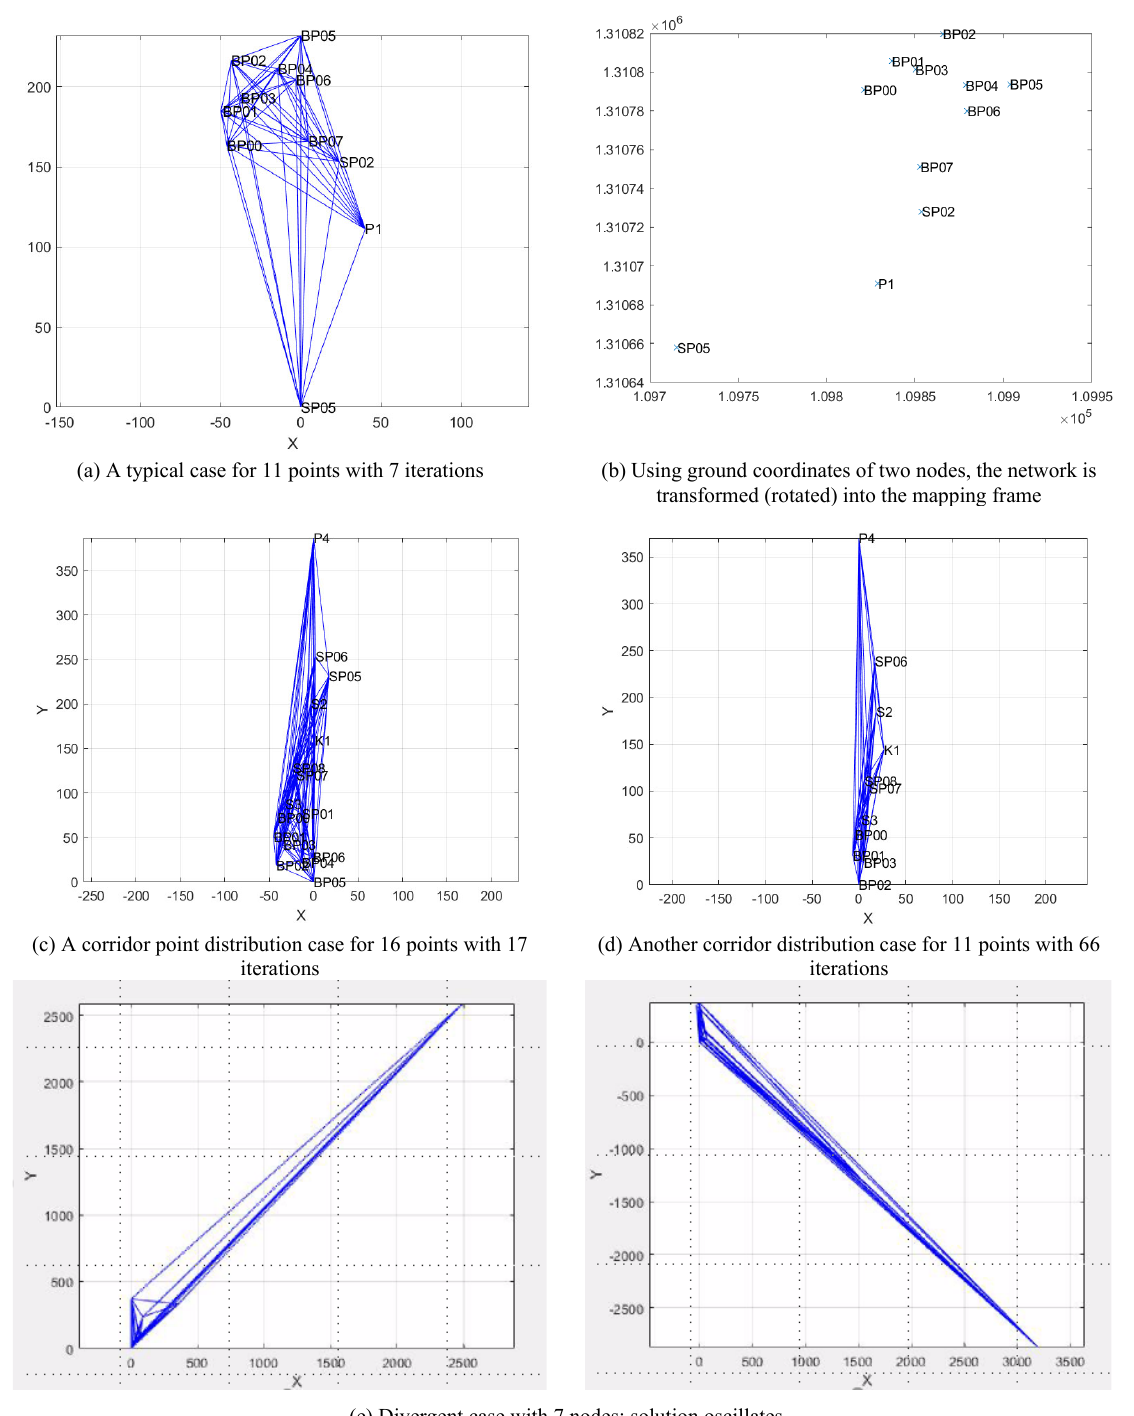
Figure 3 . Various network